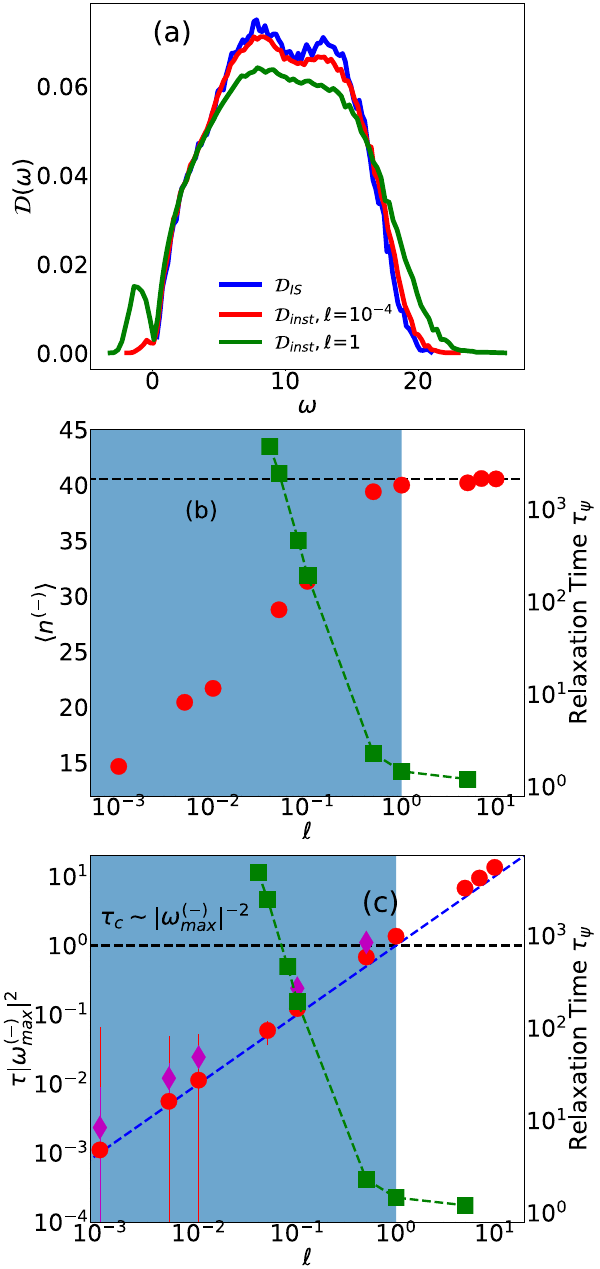
Fig. 6 Instantaneous normal modes of fully polydisperse Active Brownian particles. a D ð ω Þ of inherent con fi gurations (blue curve) and instantaneous con fi gurations at different persistence length ( ℓ = 10 − 4 , 1, red and green, respectively.) b The average number of negative frequencies (red circles, error bar smaller than symbols, average over 100 independent con fi gurations) approaches a plateau value at large ℓ and undergoes a crossover for ℓ ~ 1 at the same point where the structural relaxation time (green squares) starts to grow for decreasing values of ℓ (blue-shaded area). c The largest negative frequency in unit of persistence time τ (red circles) as a function of persistence length ℓ is order 1 at the crossover. Magenta symbols refer to lower packing fraction, i.e., ϕ = 0.66. Green squares are the structural relaxation time. The dashed blue line is τ j ω (cid:2) j 2 ¼ ‘ (error bar indicates the statistical uncertainty over 100 max independent con fi